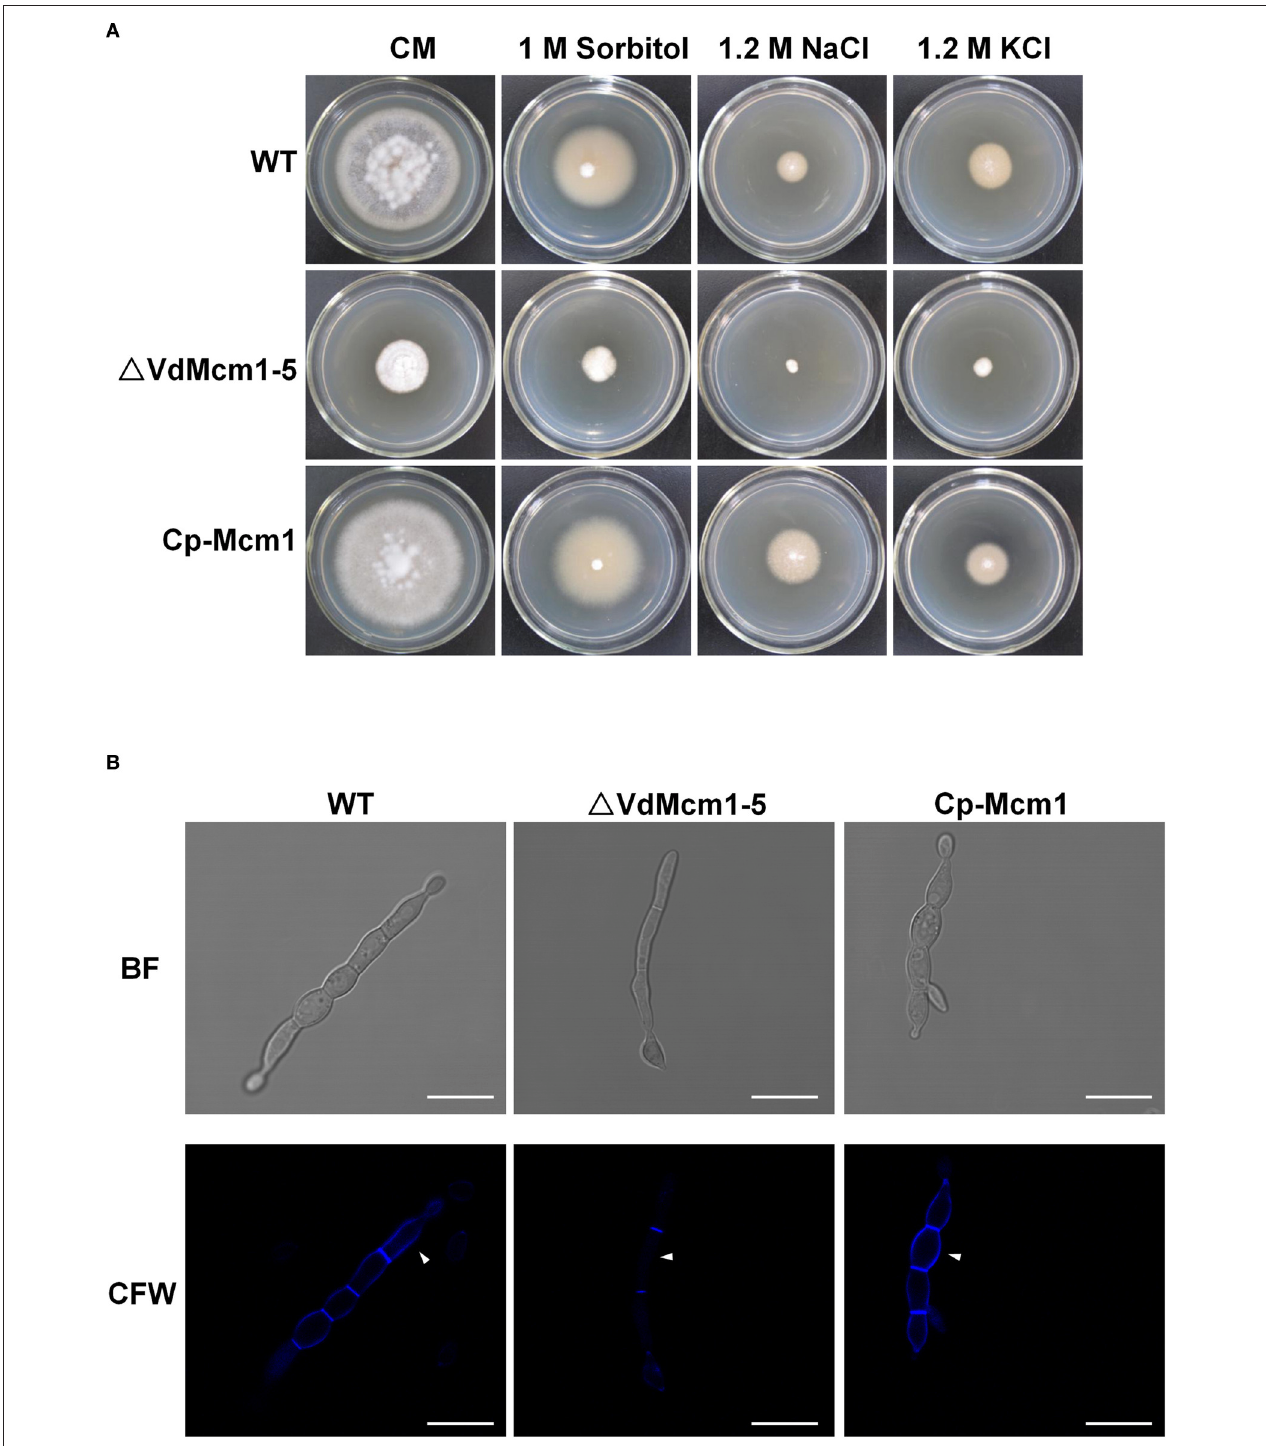
FIGURE 4 | The effect of VdMcm1 on cell wall integrity. (A) Colony morphology of the wild-type strain, 1 VdMcm1 - 5 and complemented strain after 15 days of growth on CM or CM containing 1 M Sorbitol, 1.2 M NaCl, and 1.2 M KCl. (B) Germinated conidium stained with 10 µ g/ml Calcofluor White. The white arrowheads indicate the cell wall stained with Calcofluor White. The scale bars represent 10 µ m.